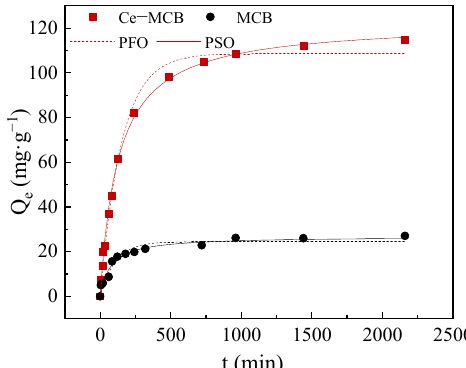
Figure 11. Pseudo-second-order and pseudo-first-order model of biochar to Pb 2+. Table 2. The fitting parameters of pseudo second-order and pseudo first-order.